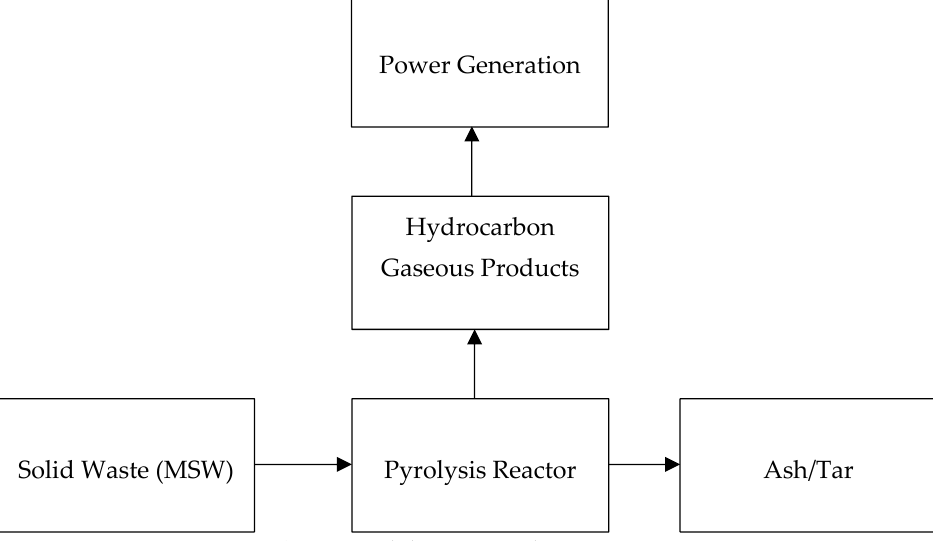
Figure 4. Solid waste pyrolysis process.